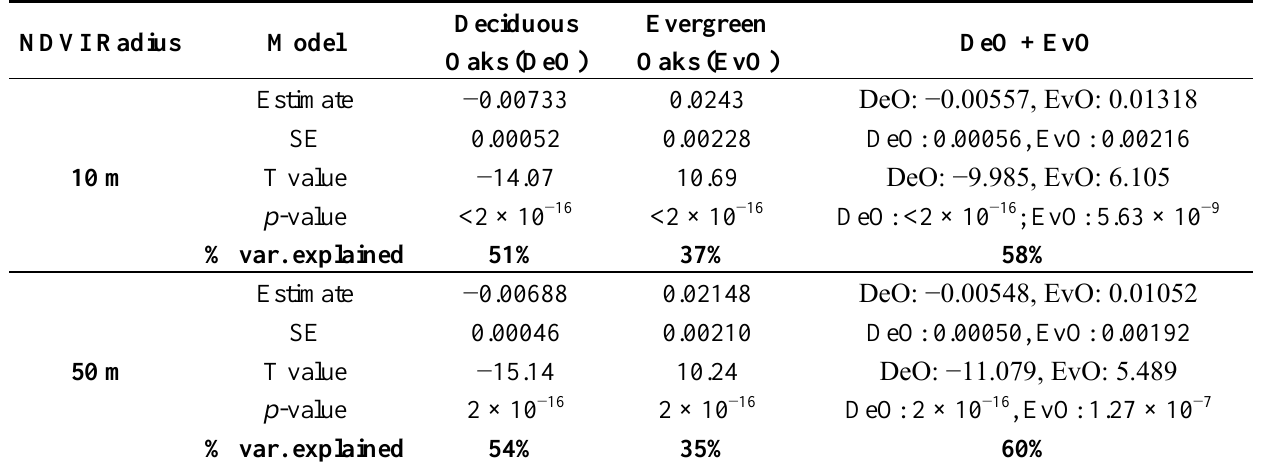
Table 1. Effect of the number of deciduous oaks (DeO), evergreen Oaks (EvO) and DeO + EvO on pixel-based winter NDVI in a 10 m and a 50 m radius around the nestbox (image acquisition: 7 February 2013).